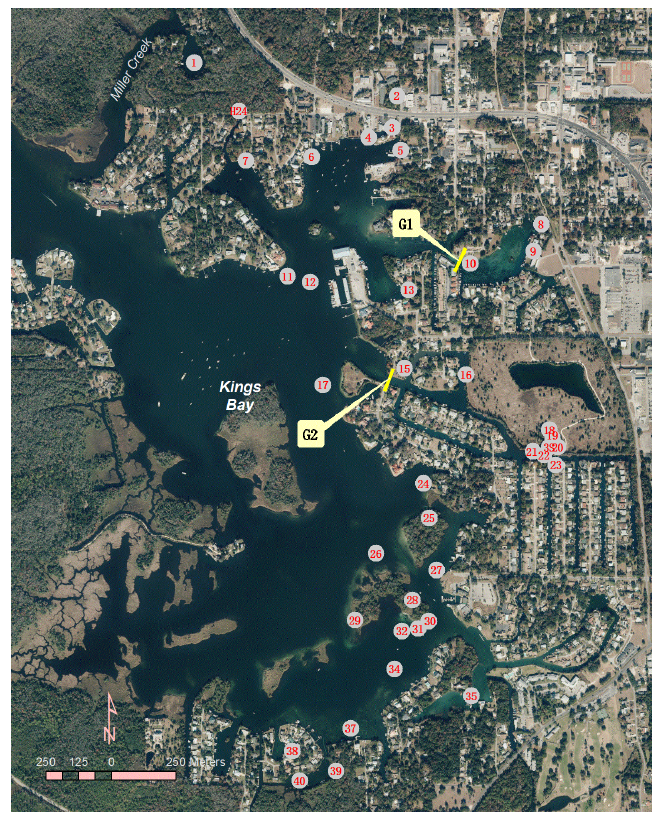
Figure 2. Locations where Group 1 (G1) and Group 2 (G2) spring flows were gauged. Identified springs are marked by white circles with numbers (for mapping purposes, springs in a close proximity are combined together sharing a single